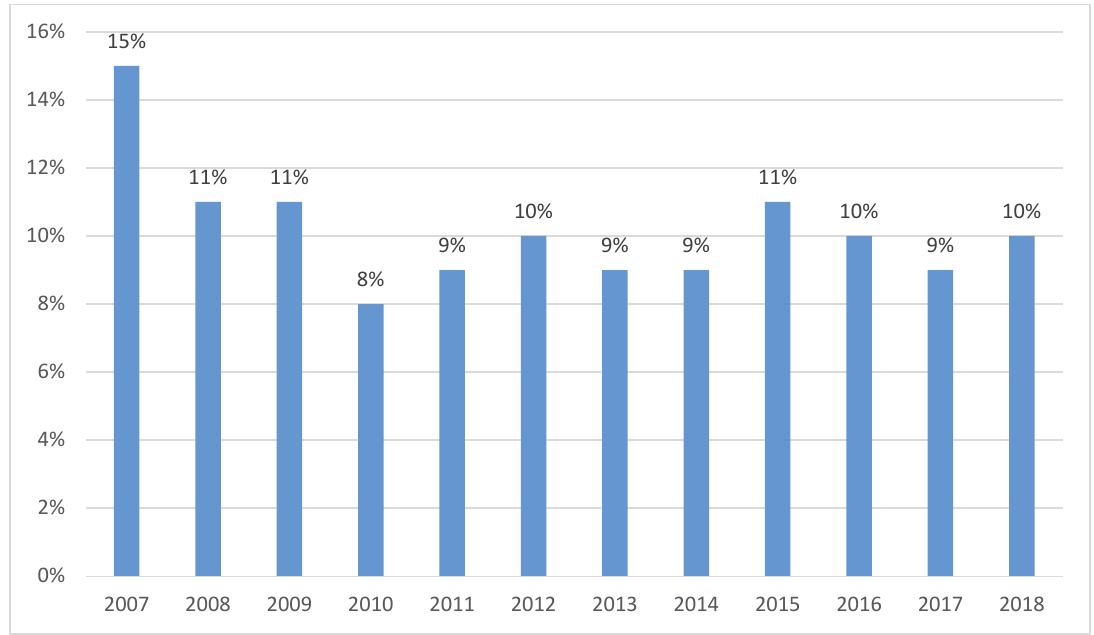
Fig. 1 . Evolution of the average cash ratio between 2007 and 2018